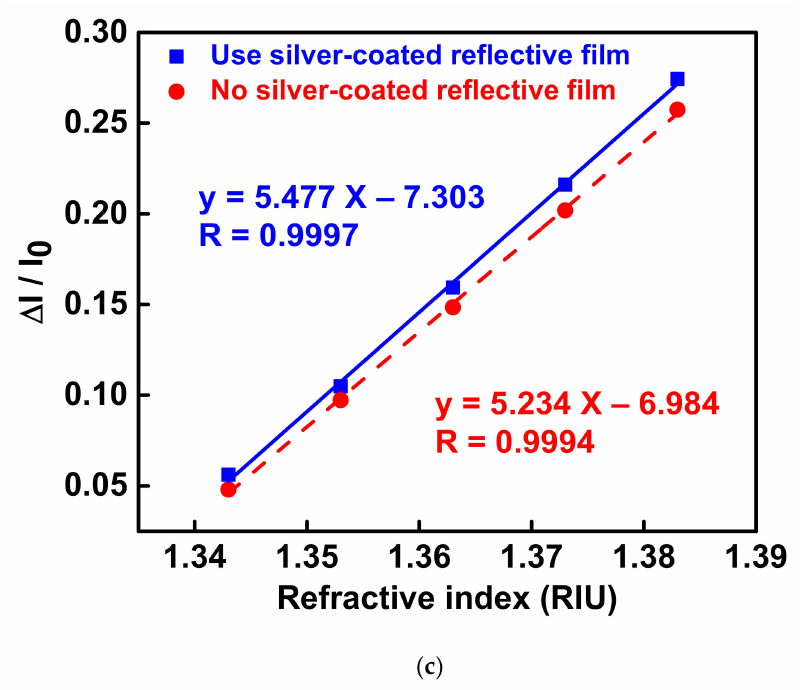
Figure 5. Real-time responses of OW LSPR sensing system for solutions with different RIs showing variation in intensity. ( a ) Different RIs are detected without reflective film (insets in panels: no reflective film added to the sensing chip). ( b ) Different RIs were detected using a silver-coated reflective film (insets in panels: add silver reflective film to the sensing chip). ( c ) Calibration curves of sensor response vs. refractive index before and after using the silver-coated reflective film (sample numbers =